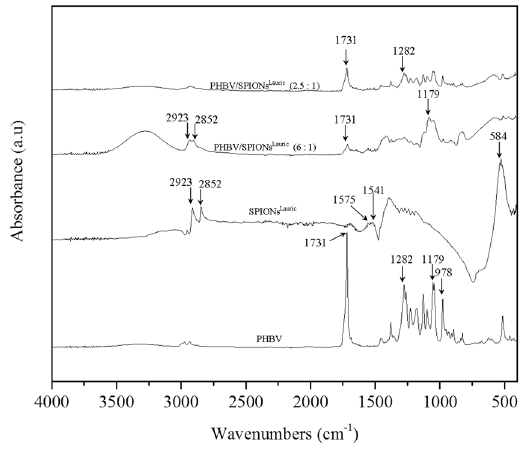
Figure 3. FTIR results on PHBV, SPIONs Lauric and PHBV incorporating SPIONs Lauric . The relevant peaks are discussed in the text.